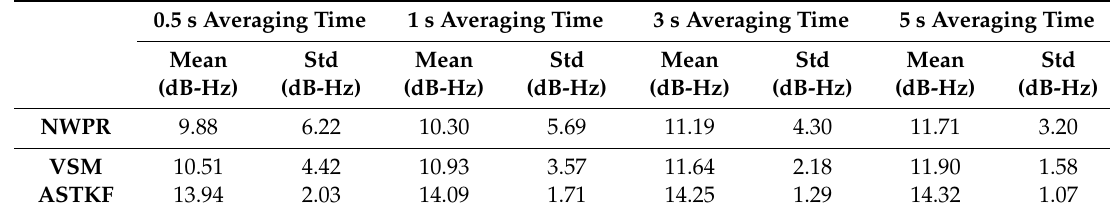
Table 4. Weak signal C / N 0 estimation statistics.